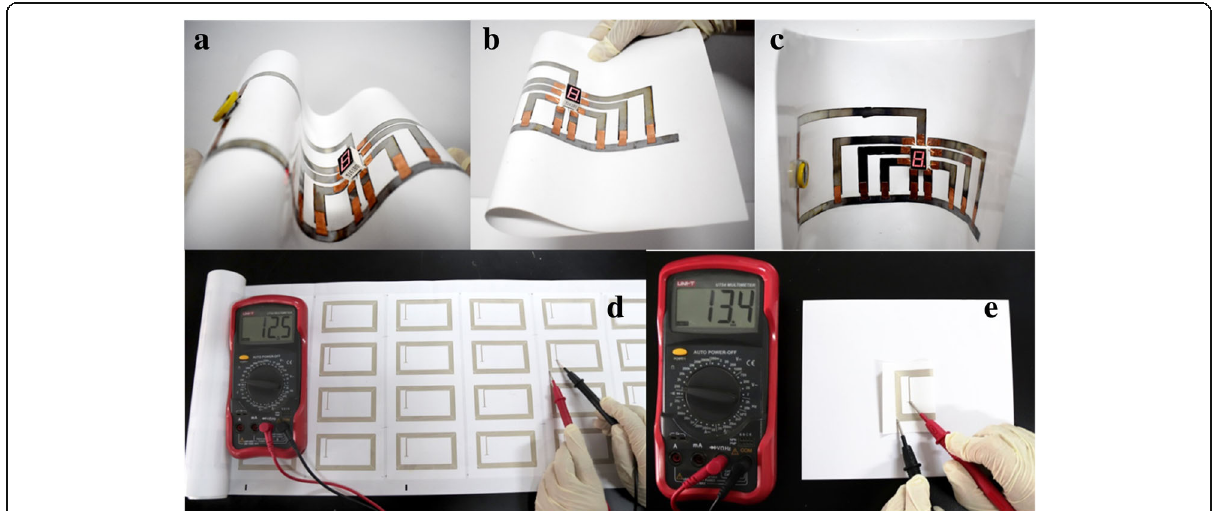
Fig. 11 a – c Hand drawn 7 segment digital LED display circuit bended in various shapes. d , e Screen printed high-frequency RFID antenna before and after